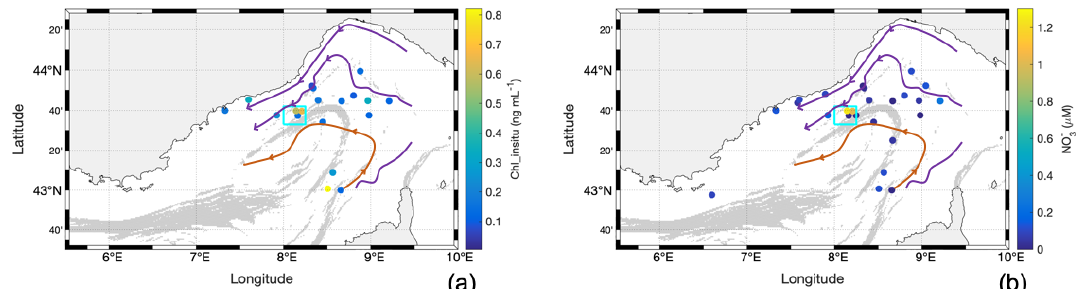
Figure 6. Water surface characteristics from discrete in situ sampling along the cruise showing the (a) Chl_insitu concentration and (b) NO − concentration. The cyan square identifies the particular TSG region of interest sampled 1d after the